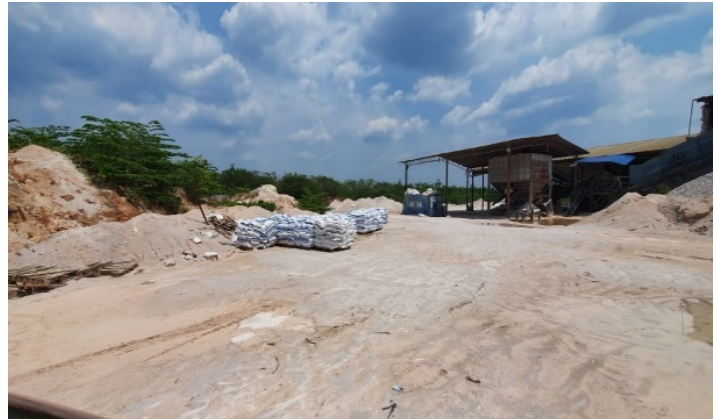
Figure 2. Dolomite quarry site in Perlis, Malaysia (own photograph).